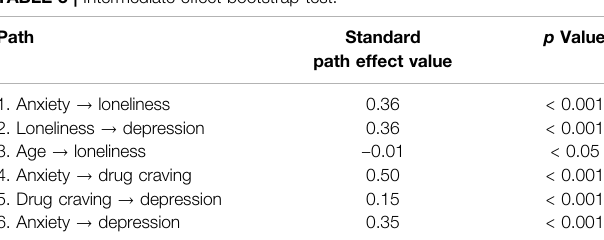
Table 3 , the path coef fi cients between anxiety and loneliness ( β (cid:1)